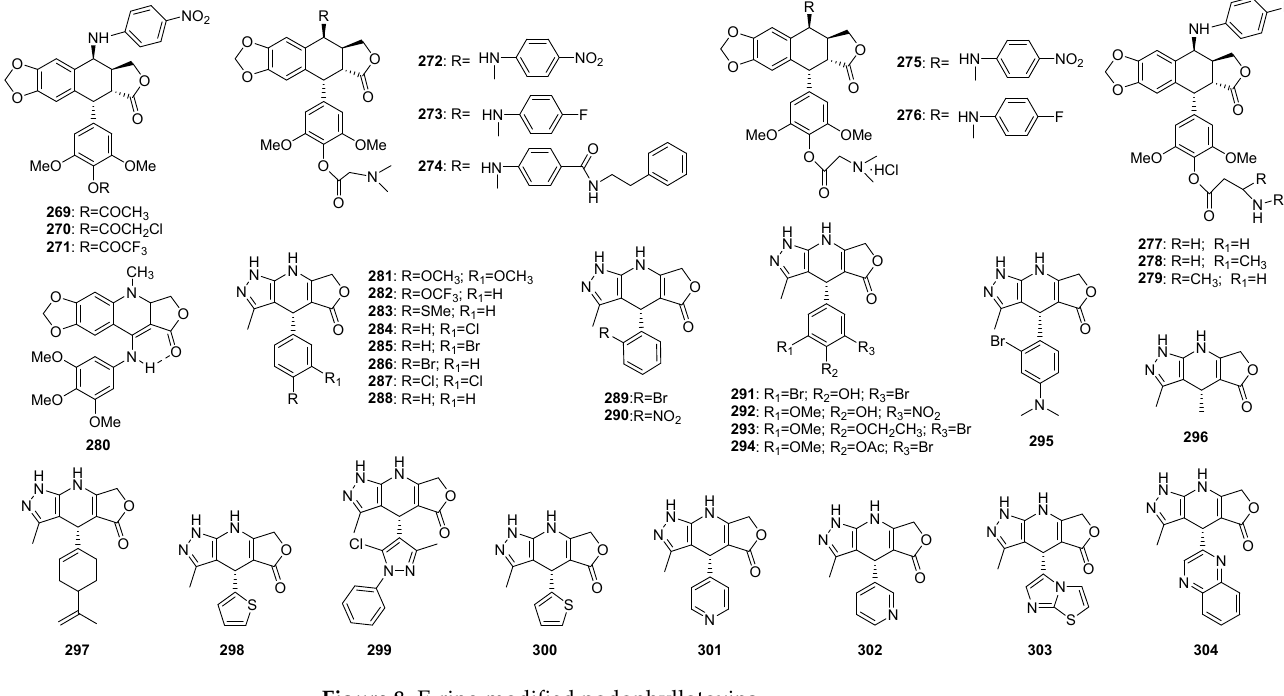
Figure 8. E-ring modified podophyllotoxins. Molecules 2022 , 27 , x FOR PEER REVIEW